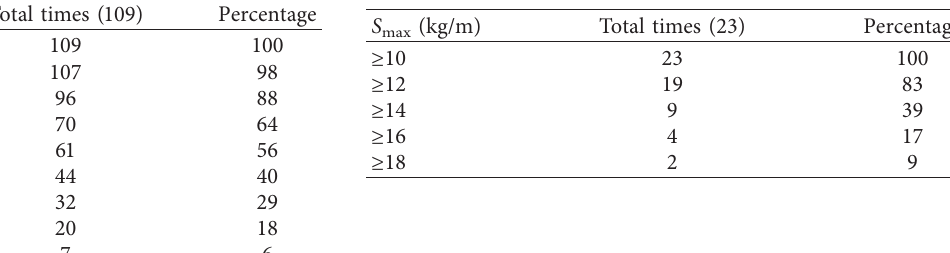
Table 12: Distribution of percentages of gas desorption max